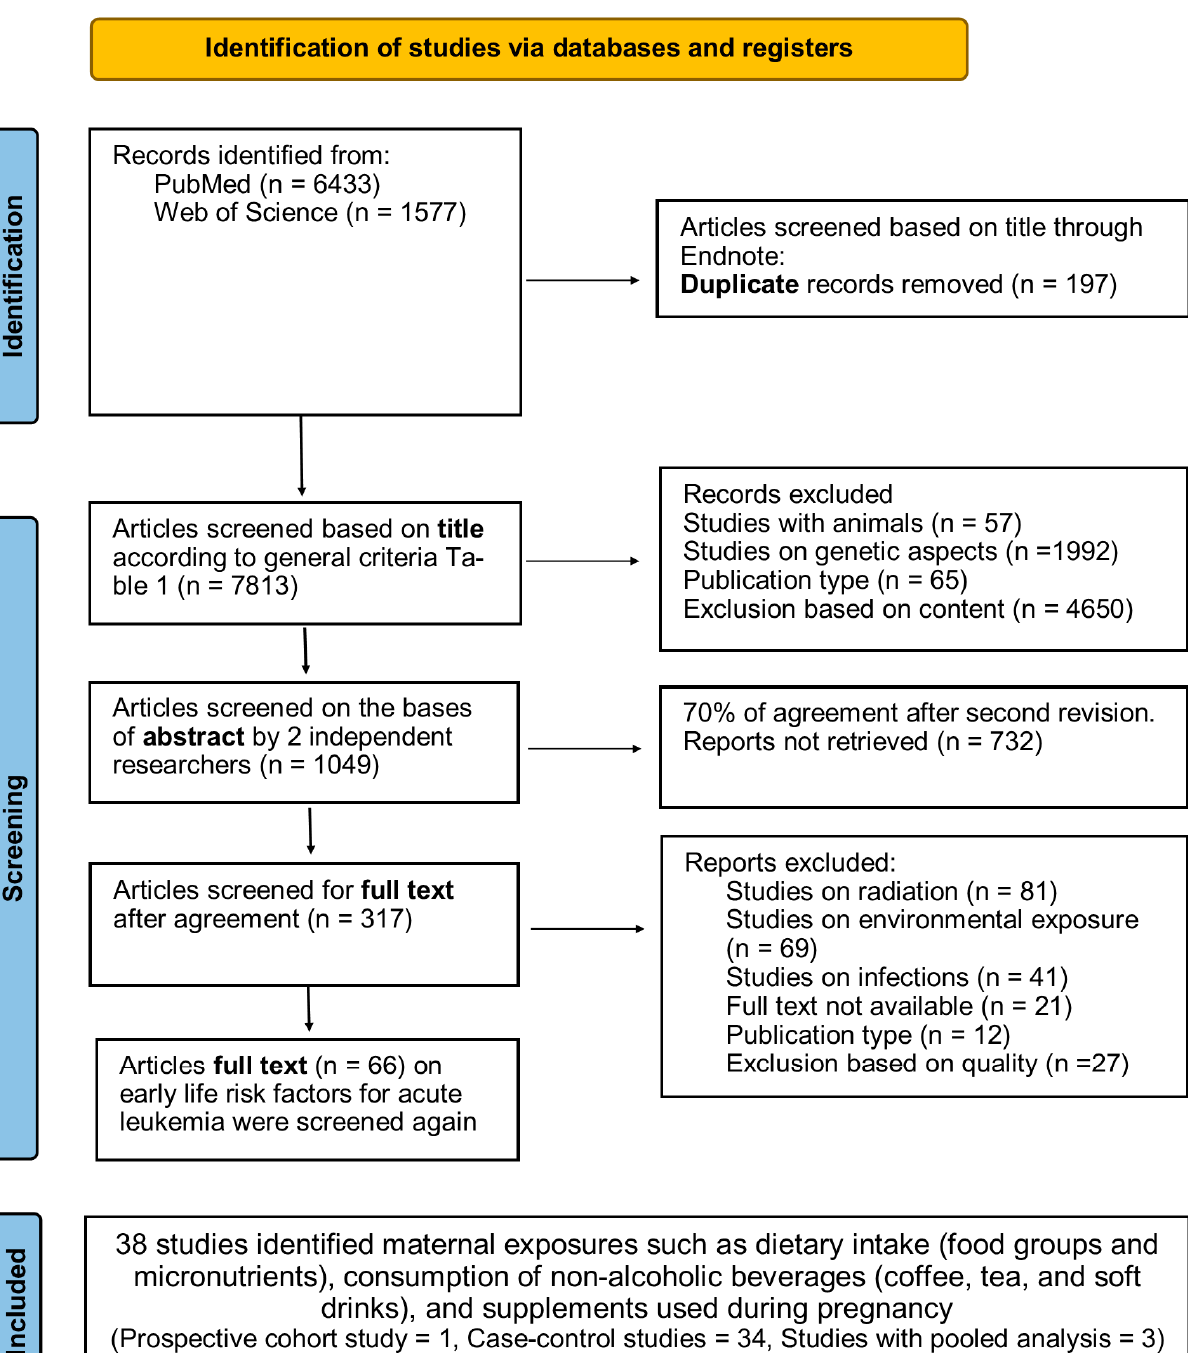
Figure 1. Search Figure 1. Search Strategy.